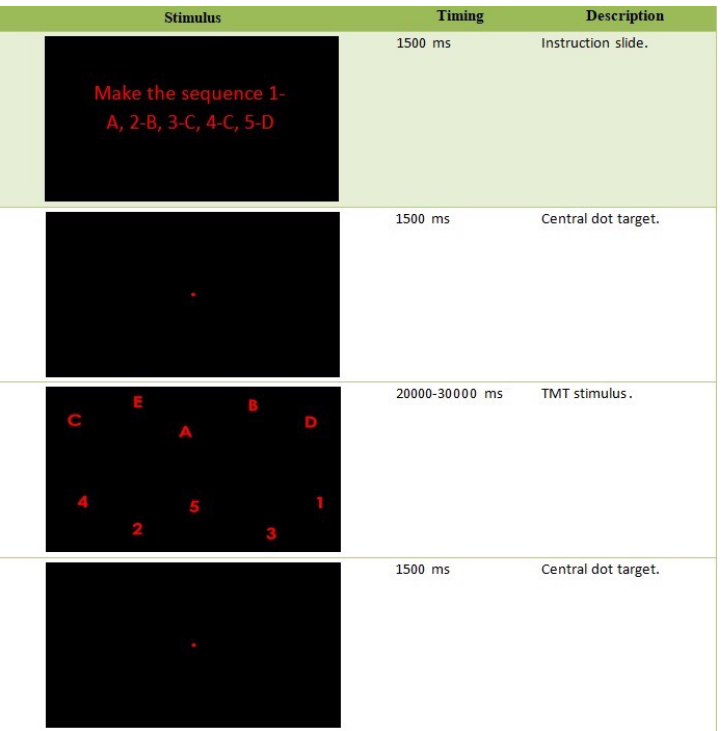
Figure 2. Stimuli timing: the instruction slide is codified with “NaN”; the central dot target is codified with “0”; the TMT stimulus is codified with